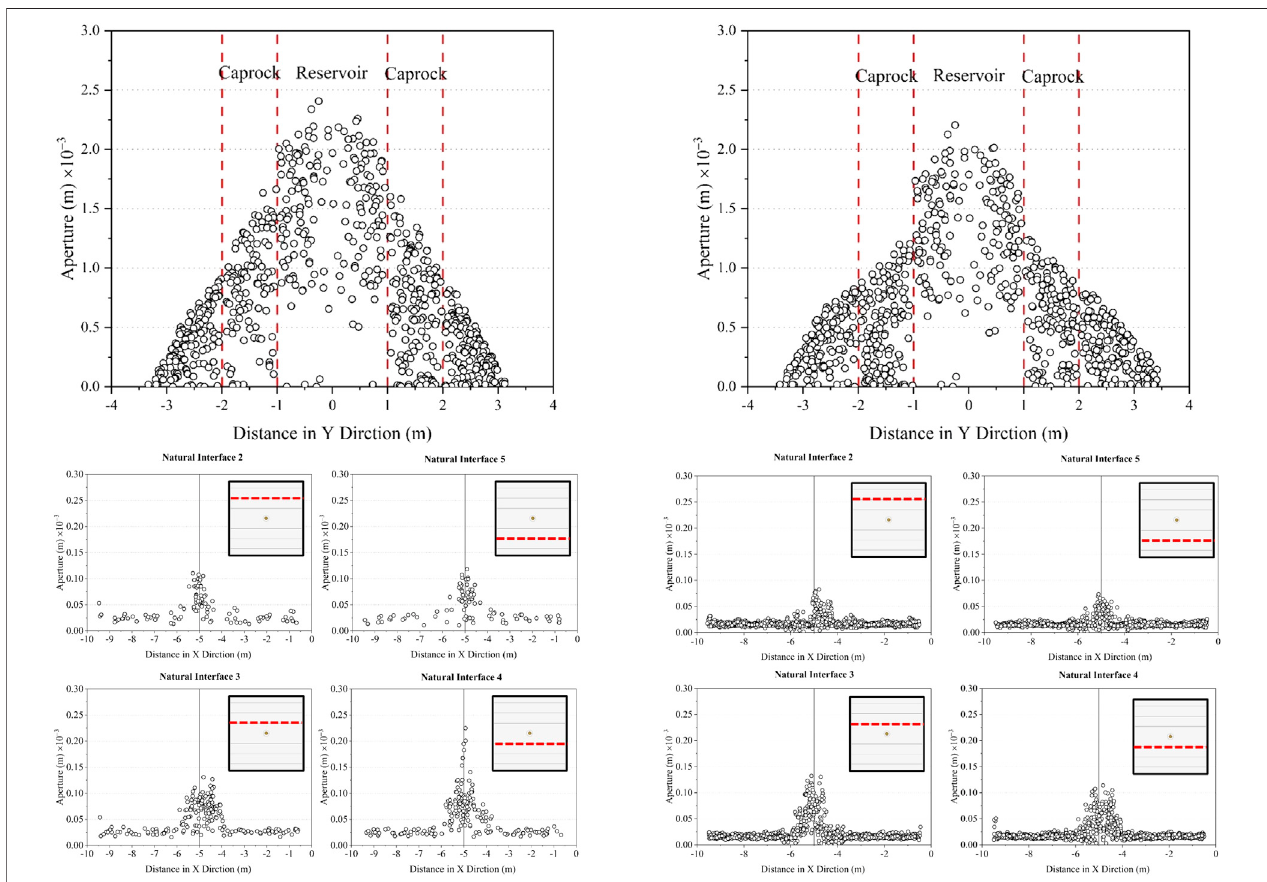
FIGURE5| Pro fi lesoftheHFapertureintheYZplaneatX (cid:2) − 5 mforcaprockYoung ’ smodulusof (A) 20 MPaand (B) 60 MPa.ThewellboreinjectionpointisatY (cid:2) 0 m.Pro fi lesofthenaturalinterfaceapertureintheXZplaneatZ (cid:2) 4 mforcaprockYoung ’ smodulusof (C) 20 MPaand (D) 60 MPa.TheHFcrosssectionappearsatX (cid:2) − 5 m. The diagram in the upper right shows the position of the corresponding natural fracture in the model.